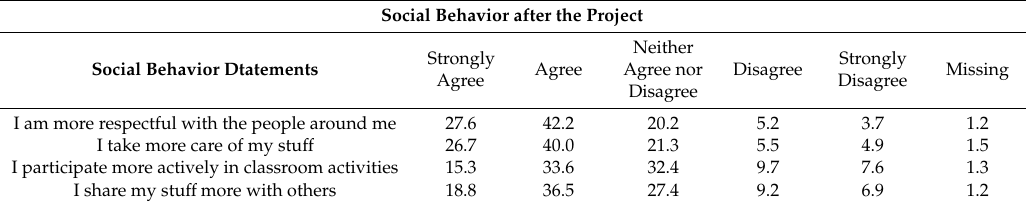
Table 10. Social behavior after the project.